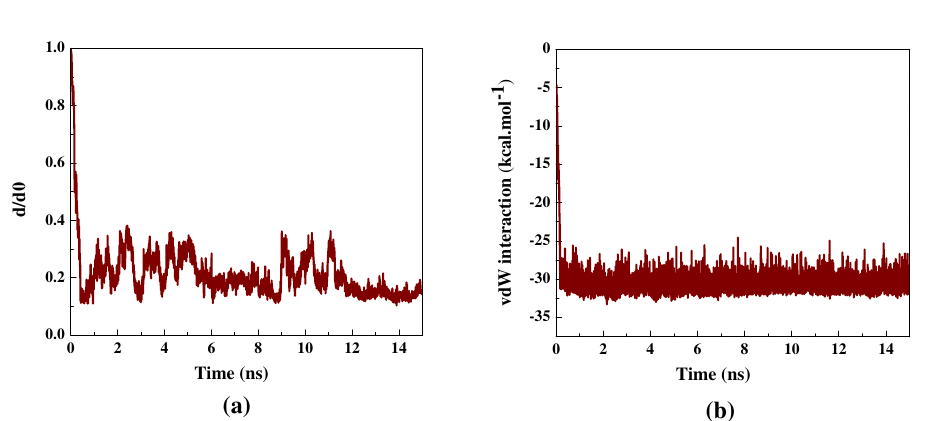
Figure 3. ( a ) The d/d 0 values (normalized to the CoM distance, where d 0 is the initial CoM distance) between the drug Isatin and capped SWCNT (10,10) as a function of simulation time, ( b ) the vdW interaction between the drug Isatin and the capped SWCNT as a function of simulation